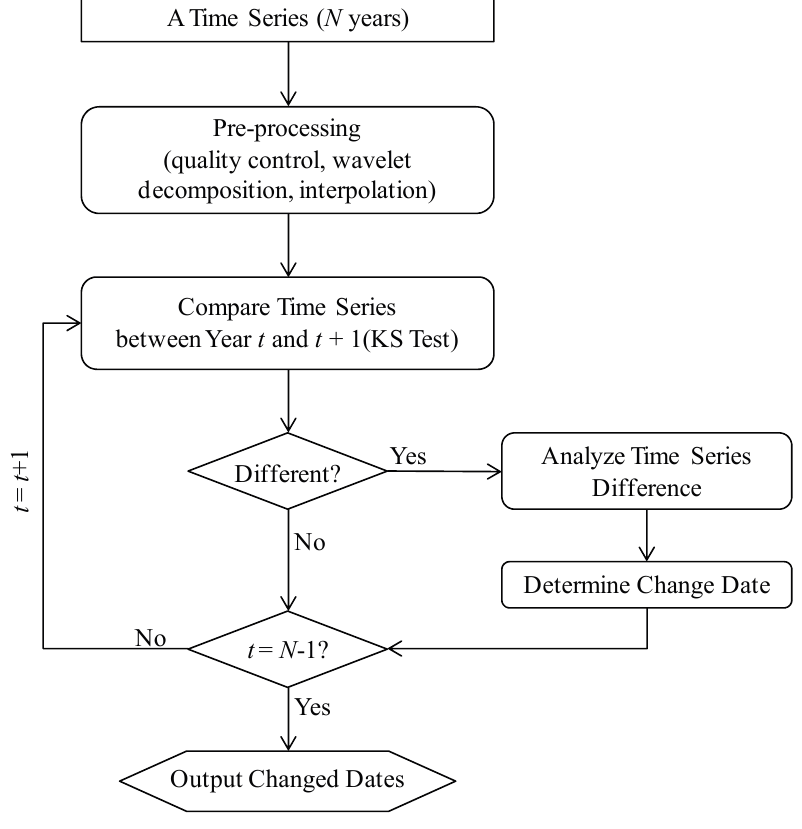
Figure 2. Flow chart of the proposed method for detecting change date in a time